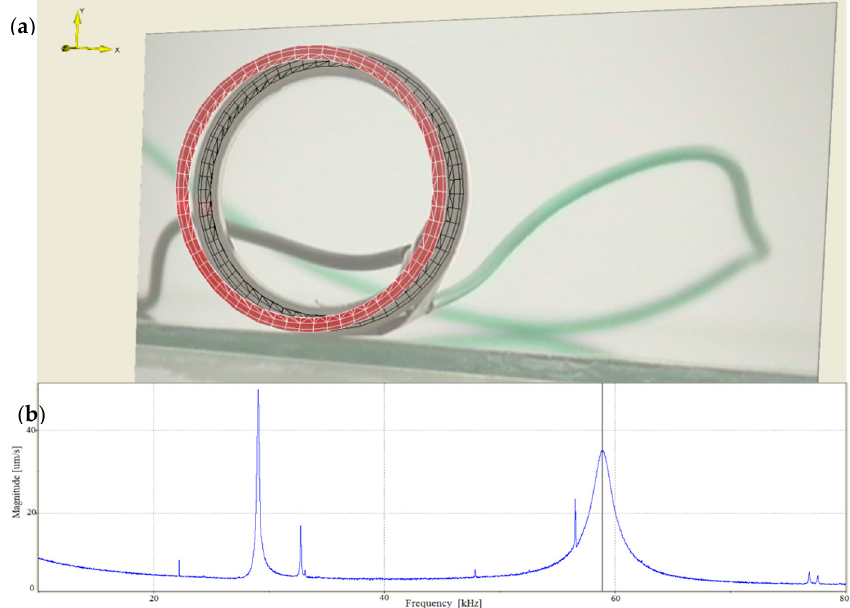
Figure 8. ( a ) The longitudinal vibrational distribution on the end surface of the cylindrical transducer at the longitudinal resonance frequency; ( b ) The frequency-longitudinal vibrational velocity curve.